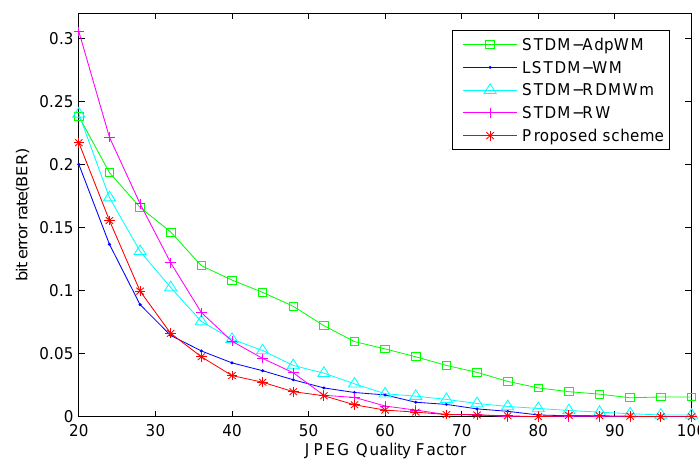
Figure 4. BER versus JPEG compression for different watermarking algorithms with SSIM = 0.982.